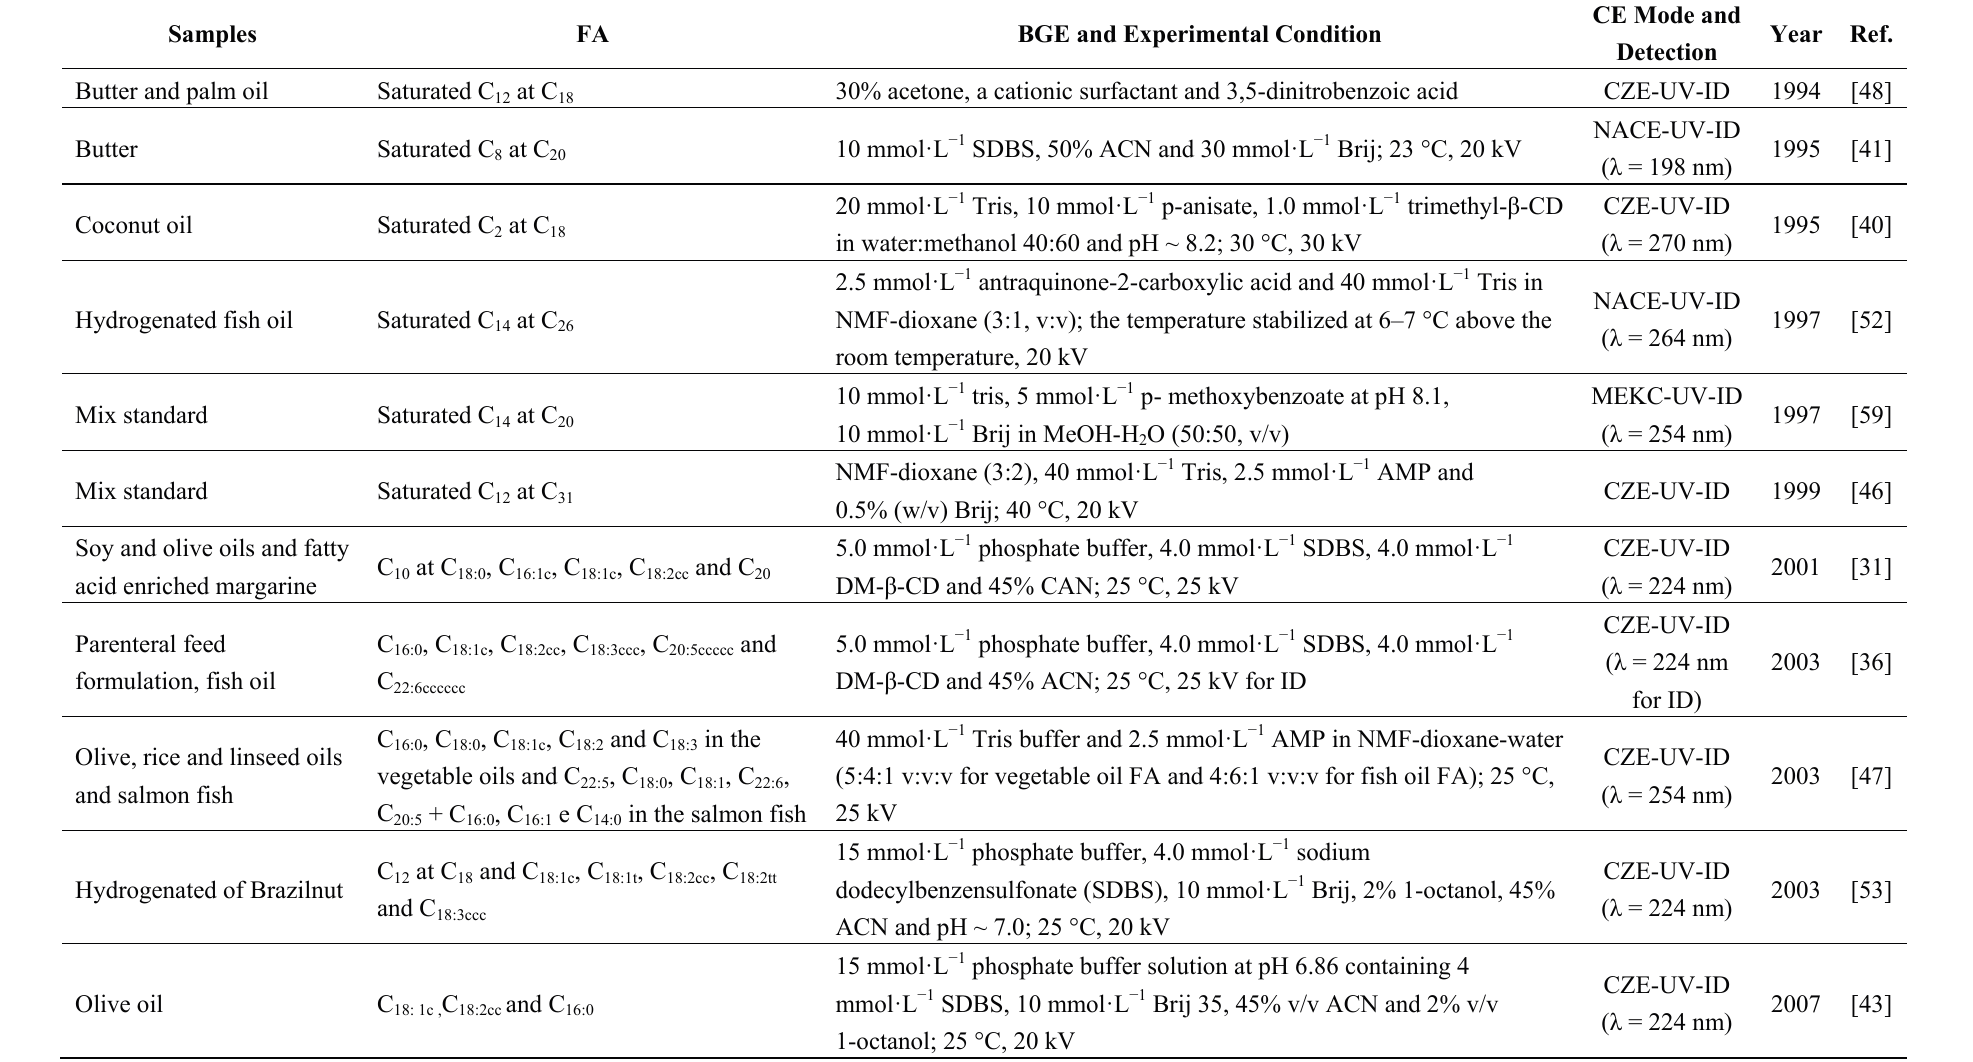
Table 2. Experimental condition, BGE and FA in different samples using UV-ID with different CE modes. NACE: nonaqueous capillary